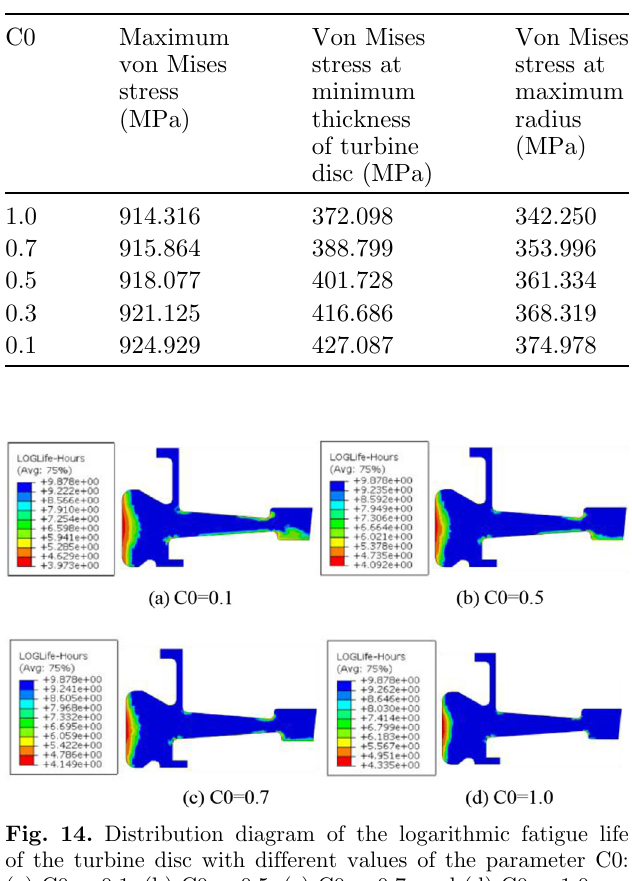
Fig. 13. Diagram of logarithmic fatigue lives of turbine discs with different values of parameter n : (a) C0 = 0.1, (b) C0 = 0.5, (c) C0 = 0.7, and (d) C0 = 1.0. Table 13. Von Mises stress at characteristic nodes of turbine disc for different C0 values.